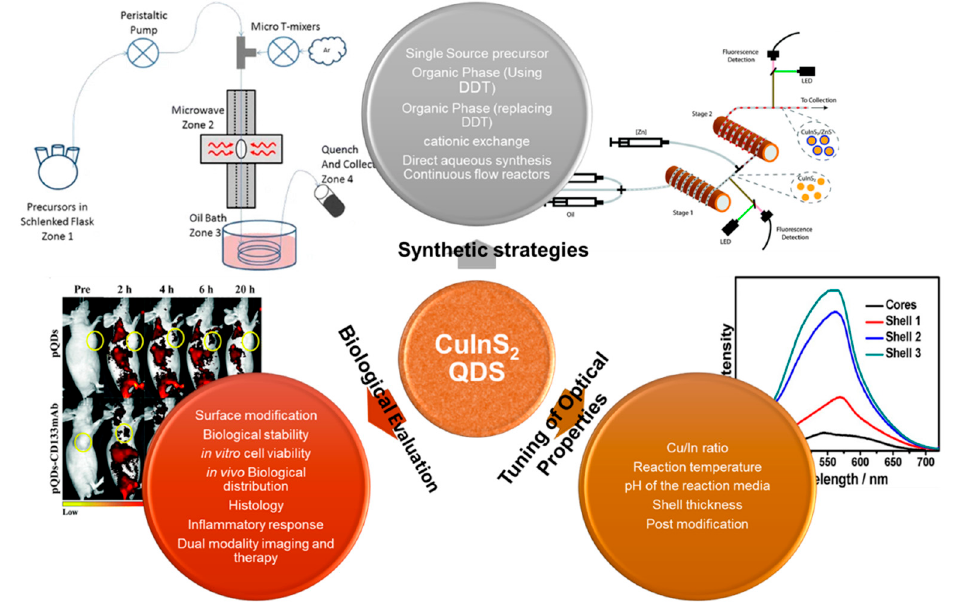
Table 1. The main synthetic strategies involved in the production of CuInS 2 (CIS)-based quantum dots